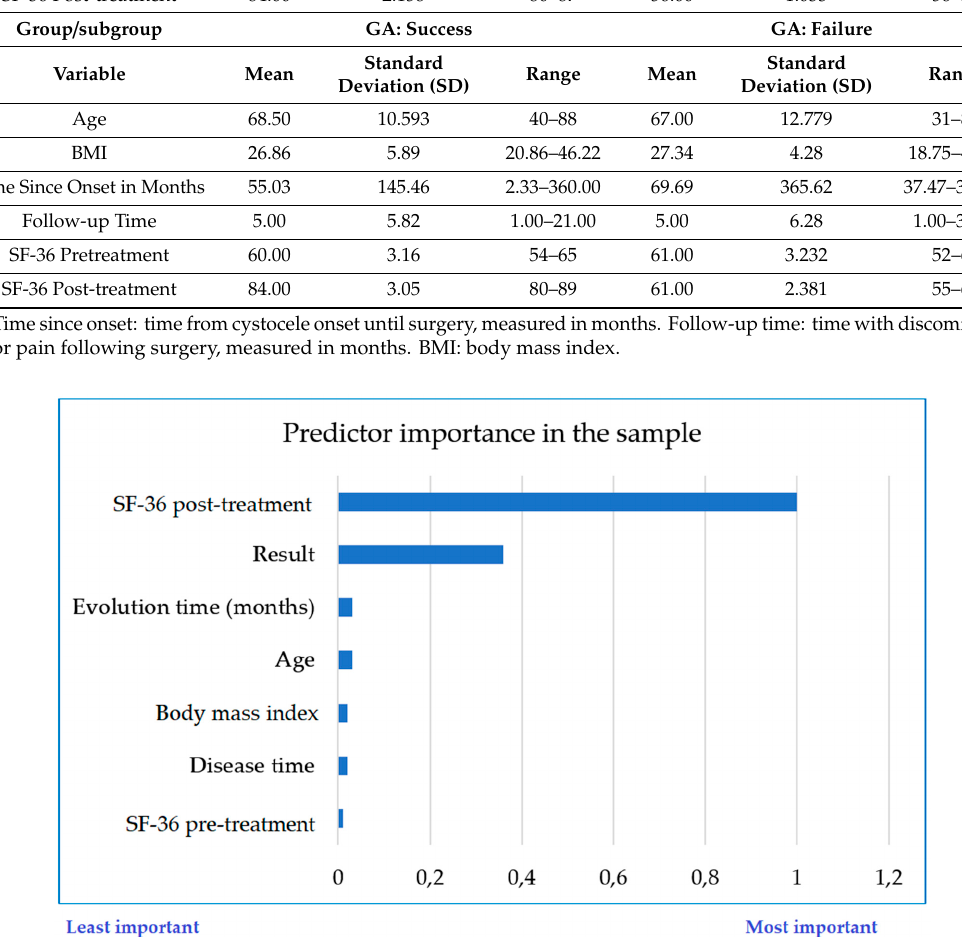
Table 1. Age, BMI, time since onset of cystocele, follow-up time, SF-36 before and after treatment.